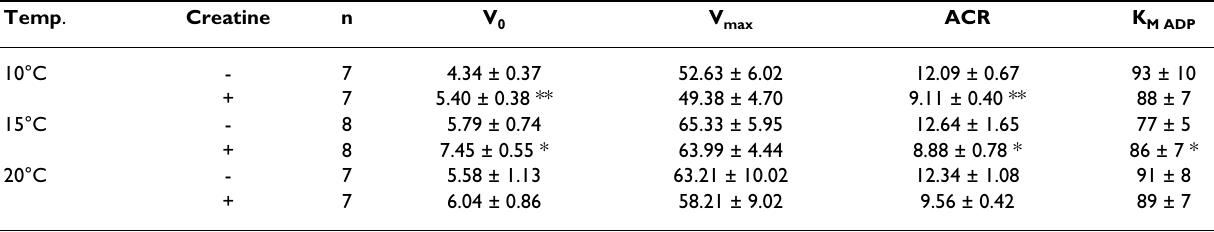
Table 4: ADP-kinetics of respiration in permeabilized cardiomyocytes Temp